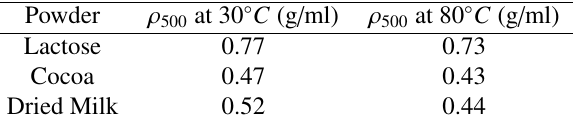
Table 1. Final (tapped) density ρ 500 at 30 ◦ C and 80 ◦ C .